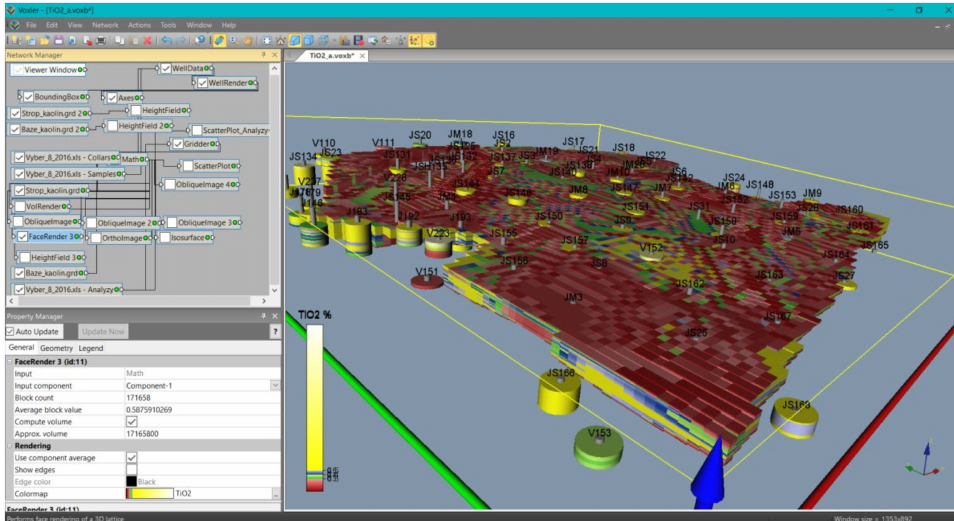
Figure 15. 3D visualization of the TiO 2 content—Plotting the 3D grid using